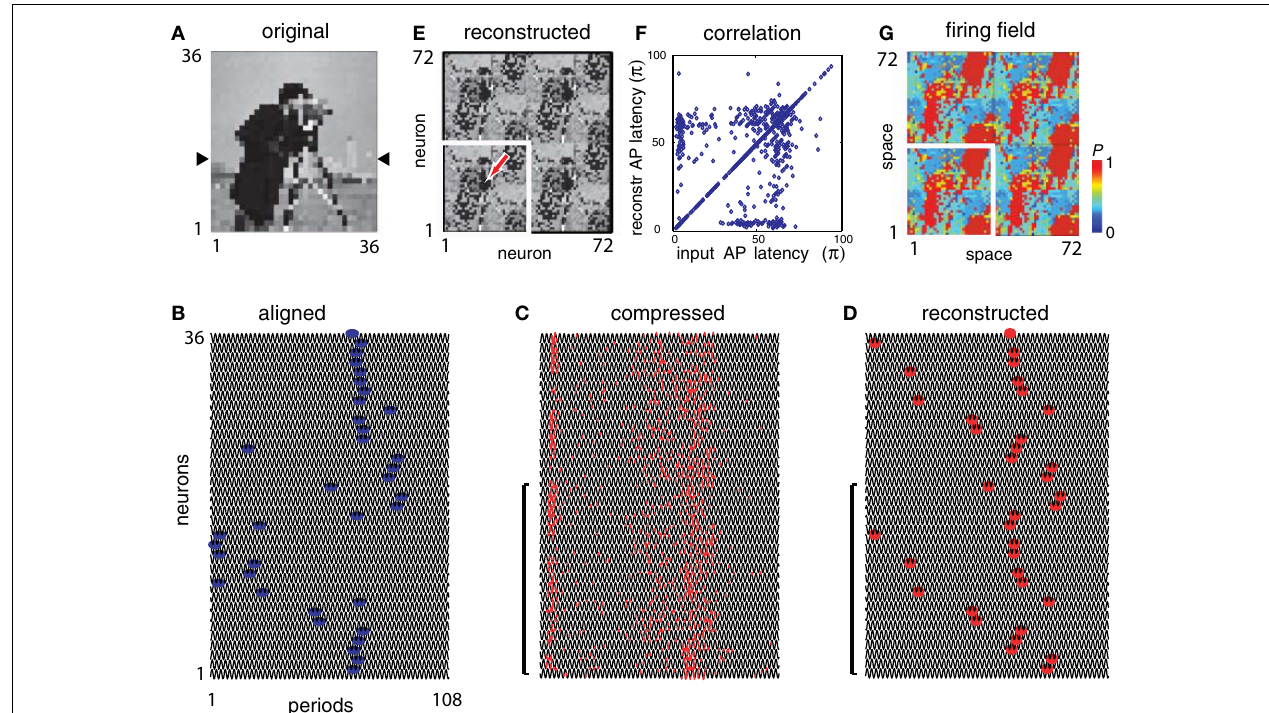
FIGURE 7 | Construction of multiple cortical representations by spurious interferences. (A) A 36 × 36 grayscale image was used as input and partitioned into 36 non-overlapping receptive fi elds, which were mapped on a 36 × 36 input neuron matrix. (B) The activity pattern of a row of neurons [between arrowheads in (A) ] that receives input from a single receptive fi eld. Blue-fi lled circles represent the APs by neurons (ordinate) after the gamma alignment, spreading through 108 cycles (abscissa). Applying a relatively steep SMO gradient ( ΔΦ = 0.1 π ) ensured that multiple neurons shared identical ( < Δτ SMO phases, thus facilitating interferences of individual APs of the compressed code with multiple target neurons. (C) The activity of 1,296 neurons total was compressed into 36 channels (one receptive fi eld per neuron). APs are represented by red dots. (D) The spatio- temporal pattern of APs (red-fi lled circles) after the reconstruction. Note the spatially periodic structure of the APs (a complete period is shown within the